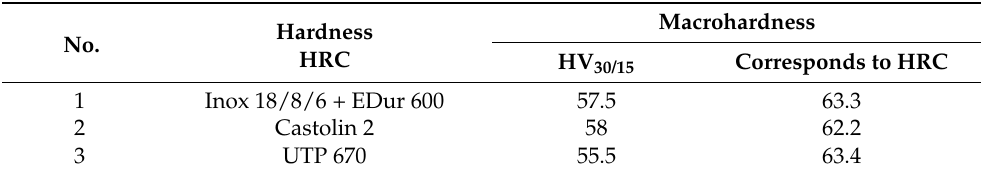
Table 7. The surface hardness and macrohardness of the hard-faced and newly manufactured samples.